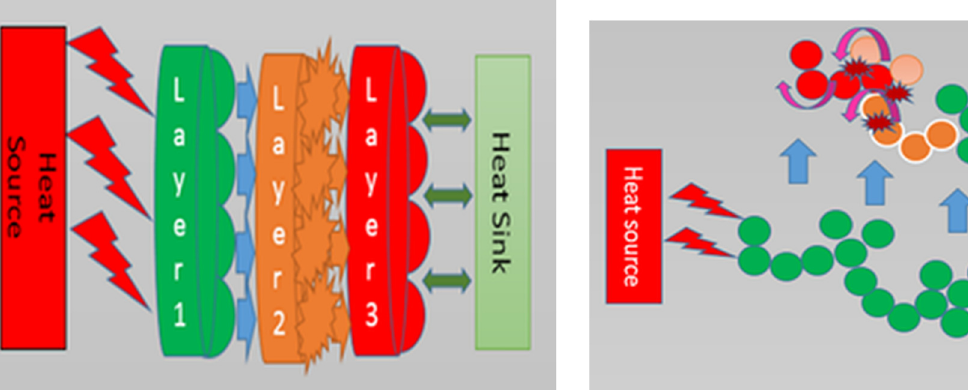
Figure 6: Crystalline domain. Figure 7: Amorphous